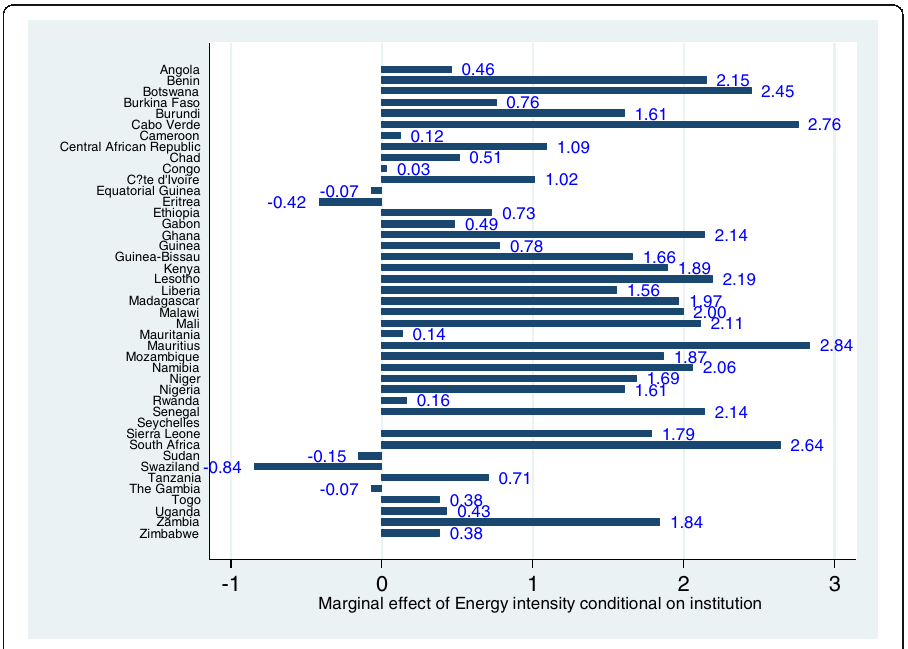
Fig. 1 Conditional marginal effect of energy intensity by